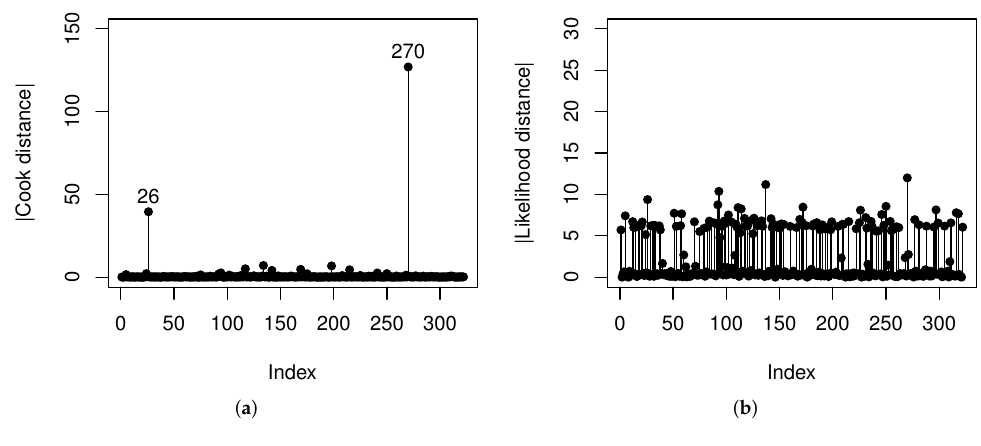
Figure 7. Index plots for ( a ) GD i ( θ ) and ( b ) LD i ( θ ) . Figure 8a displays the index plot of the residuals ( r D that they have a random behavior. Figure 8b reports the normal probability plot with a simulated envelope (Atkinson, 1987 [25]), thus revealing that the reduced OLLW regression model is appropriate for these data.